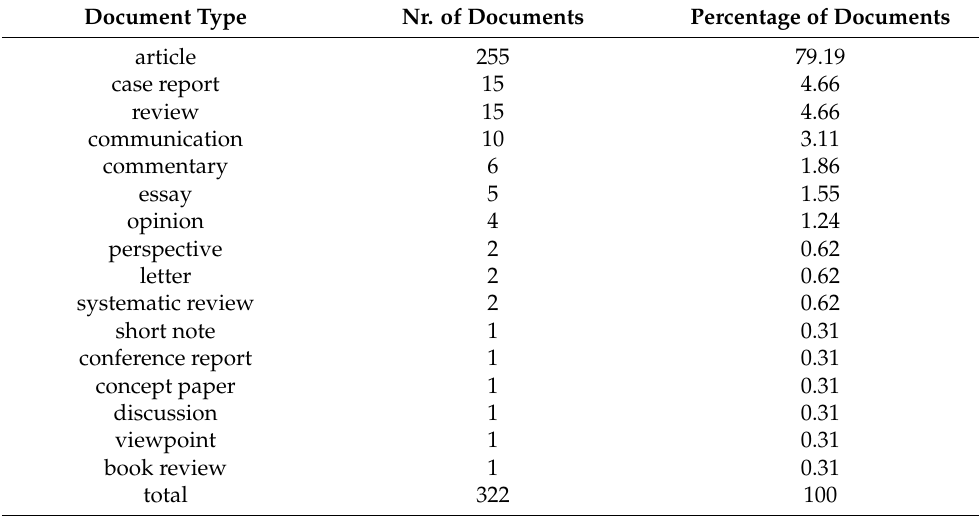
Figure 1. Papers per year, considering all 61 papers in 2022 (as of 21 December 2022). Table 4. Distributions of the document types in Publications .